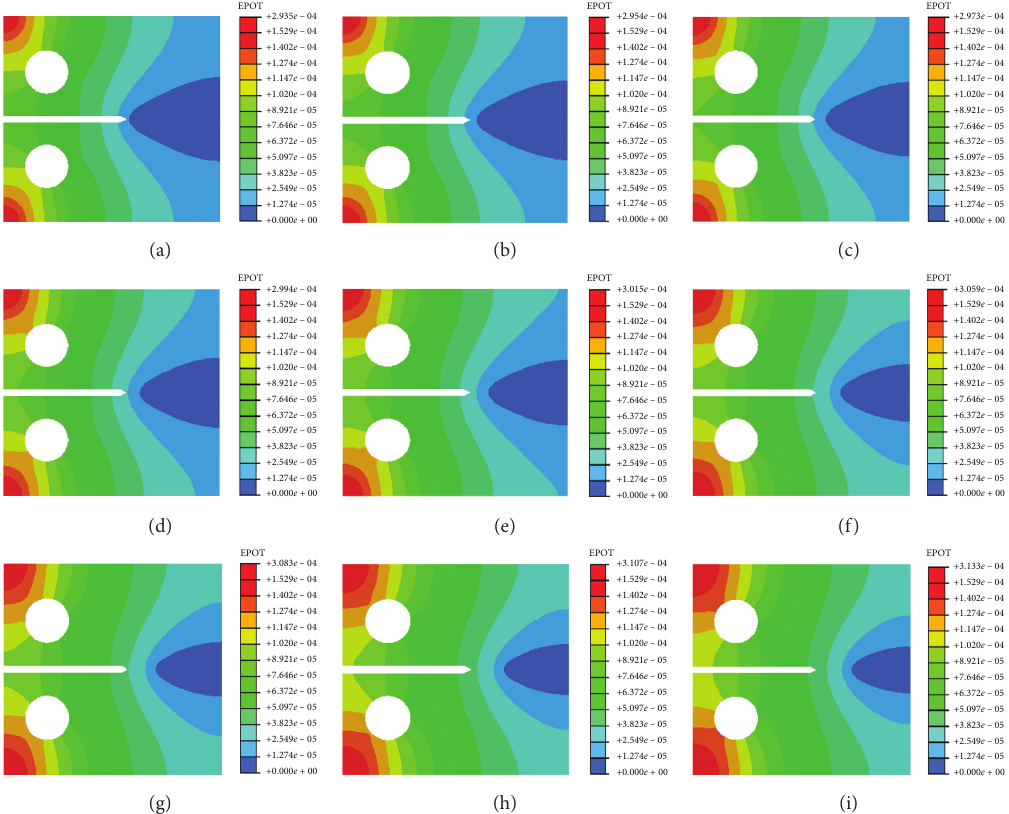
Figure 4: The potential field distribution of CT specimens: (a) a (e) a 4 � 14 mm, (f) a 5 � 14.5mm, (g) a 6 � 15mm, (h) a 7 � 15.5mm, and (i) a 8 � 16mm.